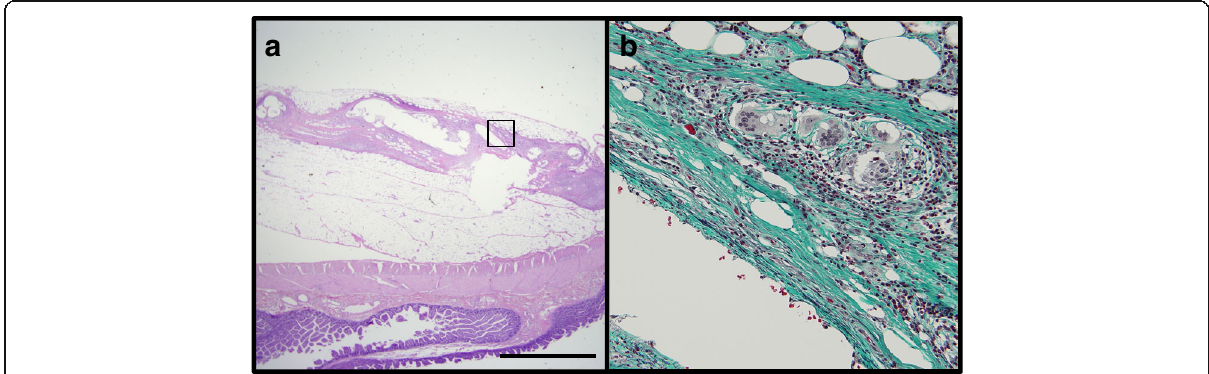
Fig. 4 Pathological examinations of the resected tissue. a Hematoxylin and eosin staining reveals thickening of the vessels in the mesentery. Scale bar, 200 μ m. b Elastica-Masson staining reveals collagenous fibrosis (green) of the vessel walls. Inflammatory cells such as lymphocytes, polymorphonuclear cells, and multinucleated giant cells are infiltrating around the vessels, suggesting focal inflammation associated with the coil embolization